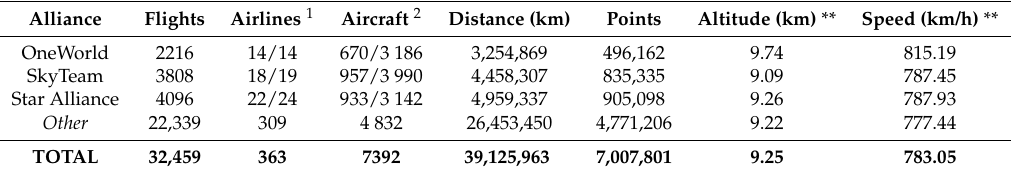
Table 5. Alliance statistics from the used